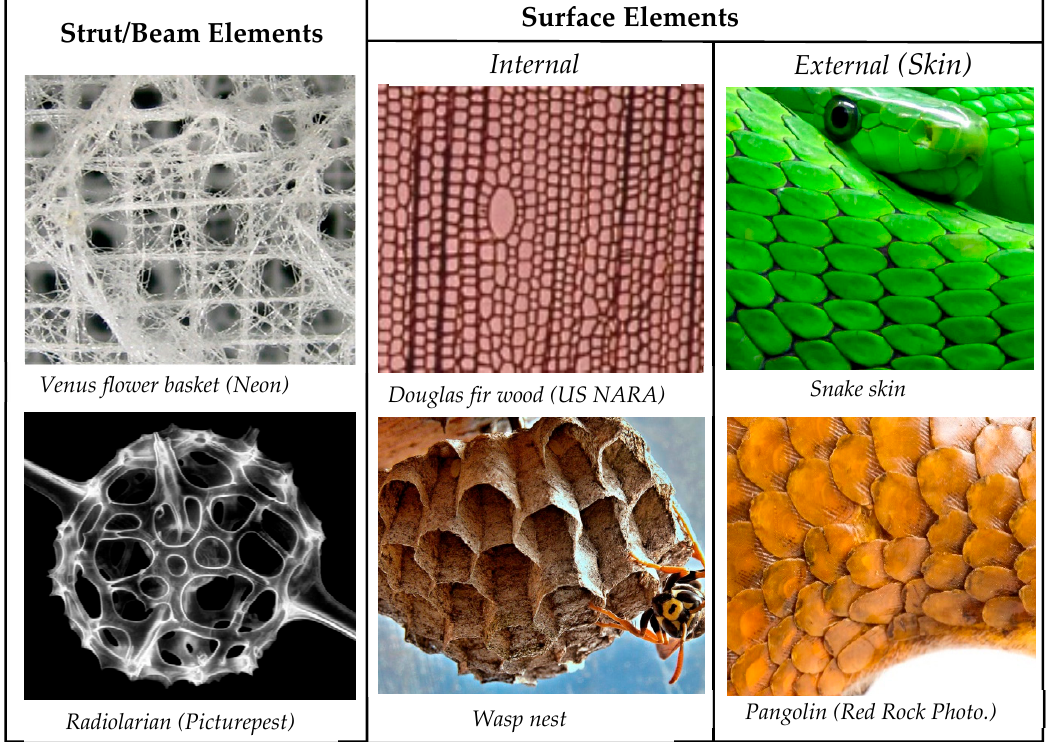
Table 4. Examples of beam and surface elements in nature.